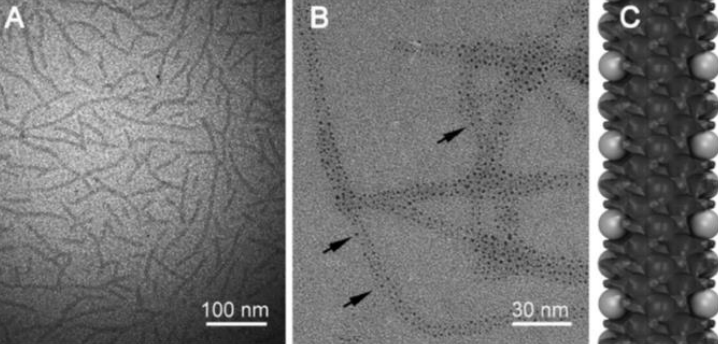
Figure 6. TEM images of ( A ) PEG-RNTs, ( B ) AuNP/PEG-RNT nanocomposite, and ( C ) model of the nanocomposite. Black arrows in ( B ) point at the AuNPs grown on the PEG-RNT surface. Abbreviations: RNT, rosette nanotube; PEG, polyethylene glycol; TEM, transmission electron microscopy; AuNP, gold nanoparticle. Reproduced from [90], with permission from Dove Medical Press, 2019.